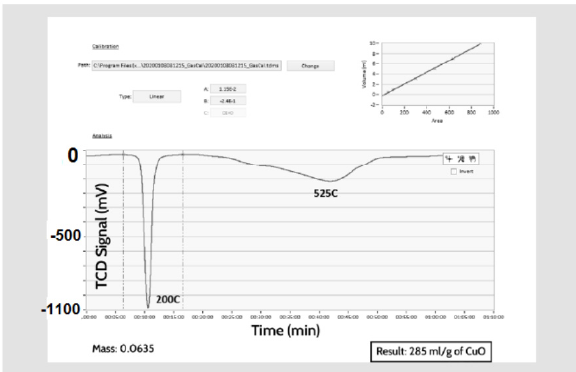
Figure 11. TPR profile on the fresh catalyst.